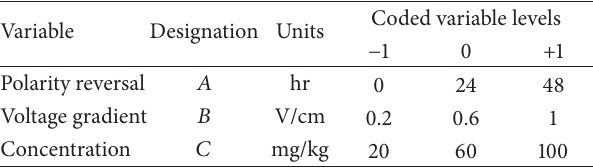
Figure 3: Weekly pH variation. Table 3: Codification and ranges of factors.